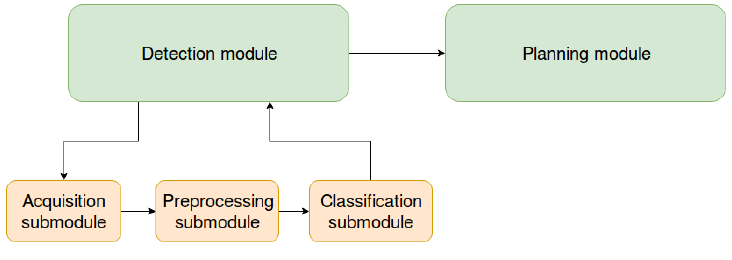
Figure 4. Structure of the